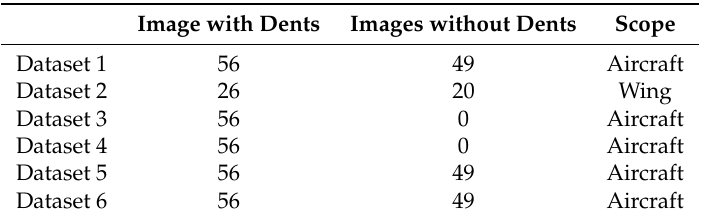
Table 2. Data set